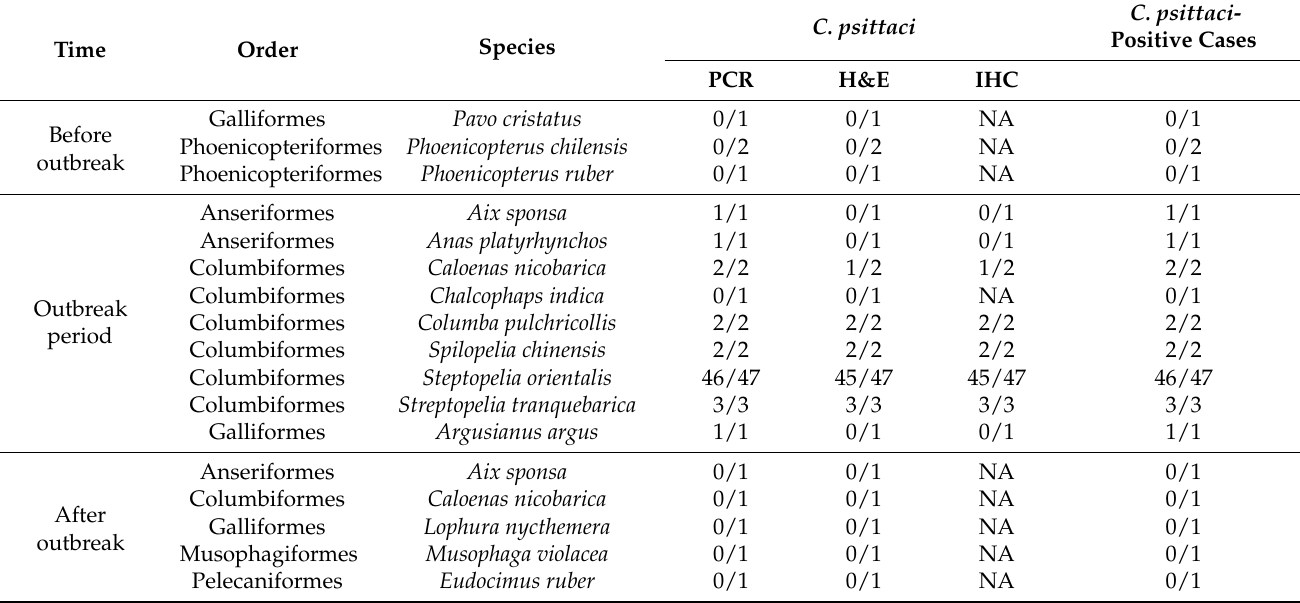
Table 2. A summary of the number of positive cases of Chlamydia psittaci in the outbreak year based on different detec- tion methods.